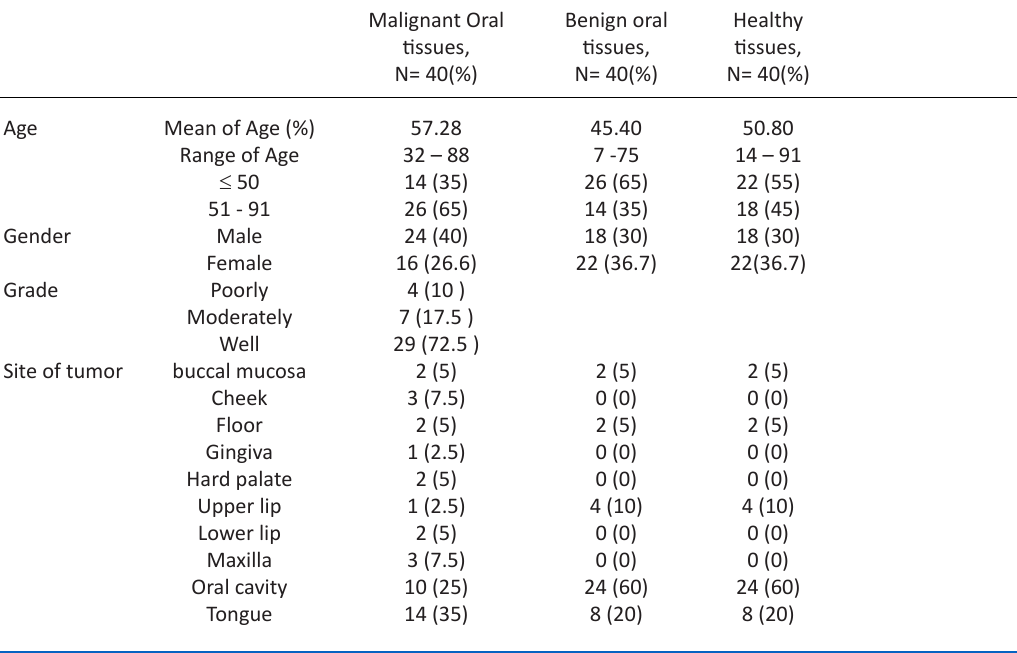
Table 1. The Study Group